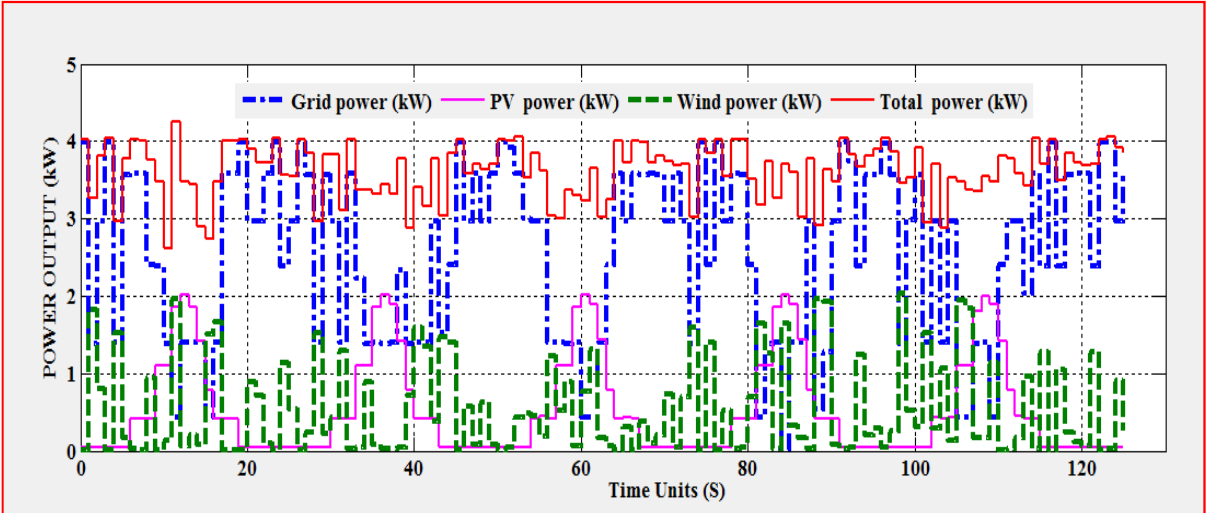
Figure 21. Grid with hybrid energy resources variations for 100-time units simulation for optimum data.